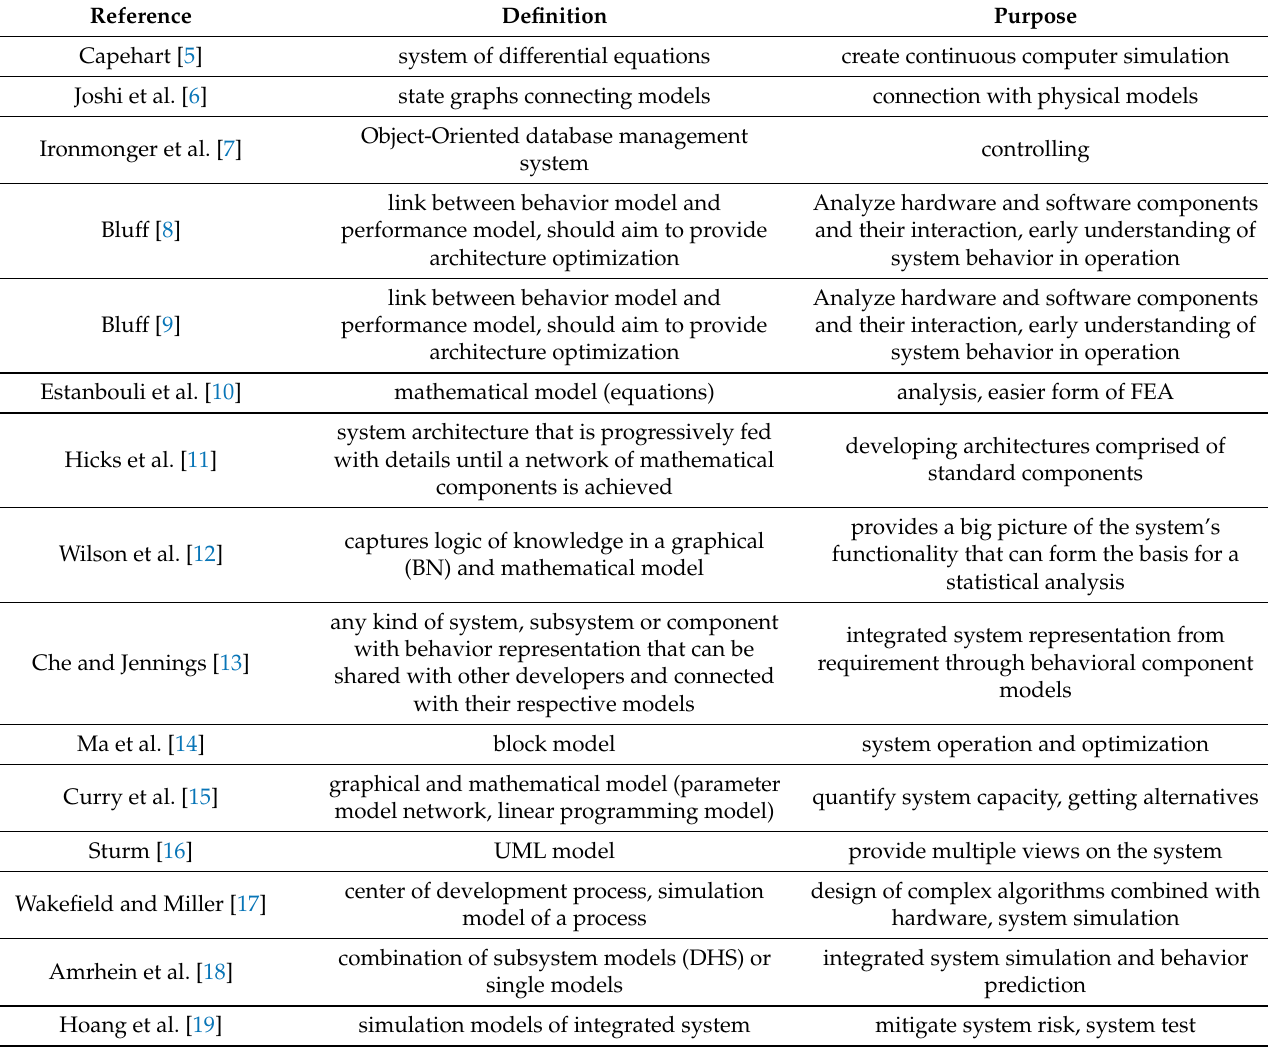
Table A6. Purpose and definition of system models extracted from eligible